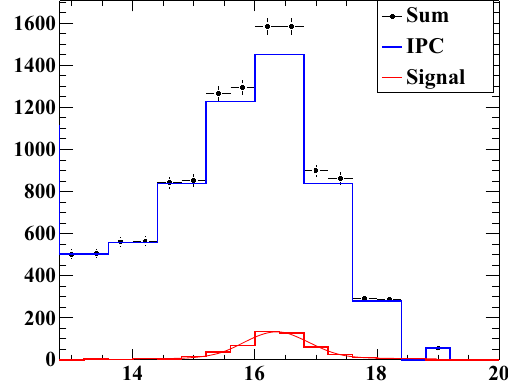
Fig. 9 Invariant mass distribution of signal and IPC background from simulations. The “sum” distribution is also